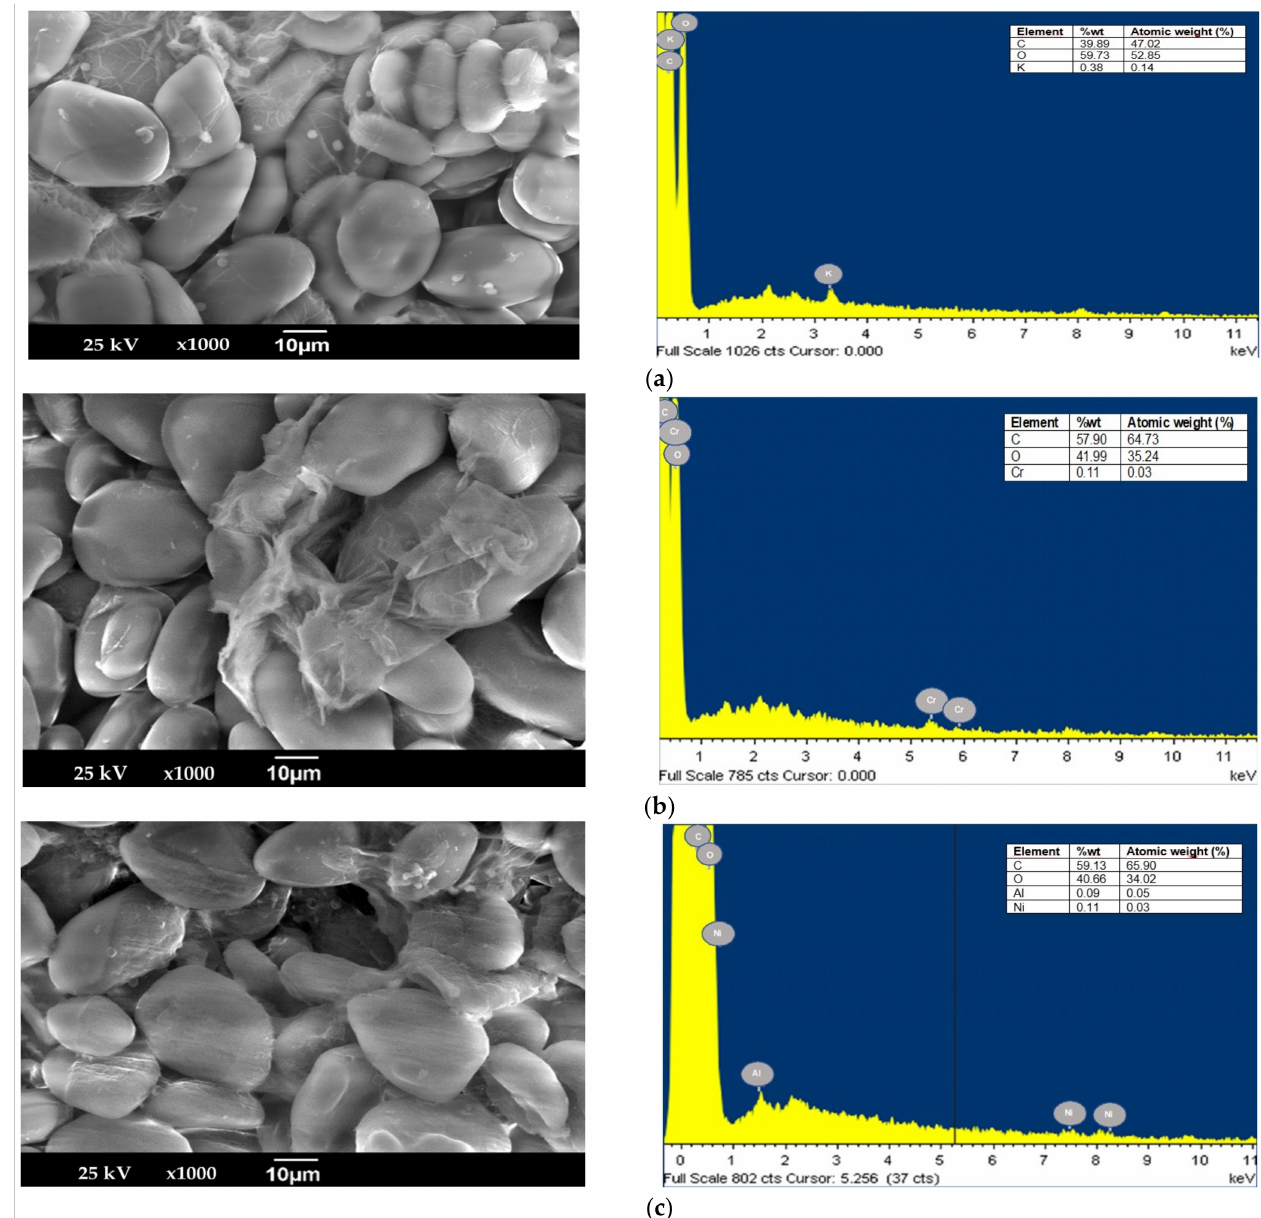
Figure 4. SEM micrographs and EDS of the YSR ( a ) natural and after adsorption of ( b ) Cr (VI) and ( c ) Ni